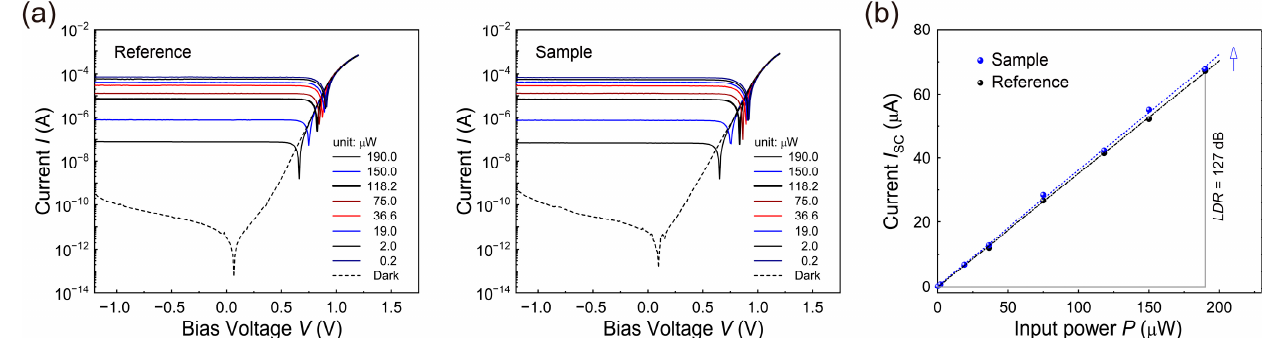
Figure 3. ( a ) Photocurrent characteristics of the MAPbI 3 photodiodes of the reference ( left ) and sample ( right ) as a function of the bias voltage for several different intensity levels of irradiating light with a wavelength of 637 nm. ( b ) I SC curves as a function of the input power of incident light (637 nm) for the reference and sample photodiodes.